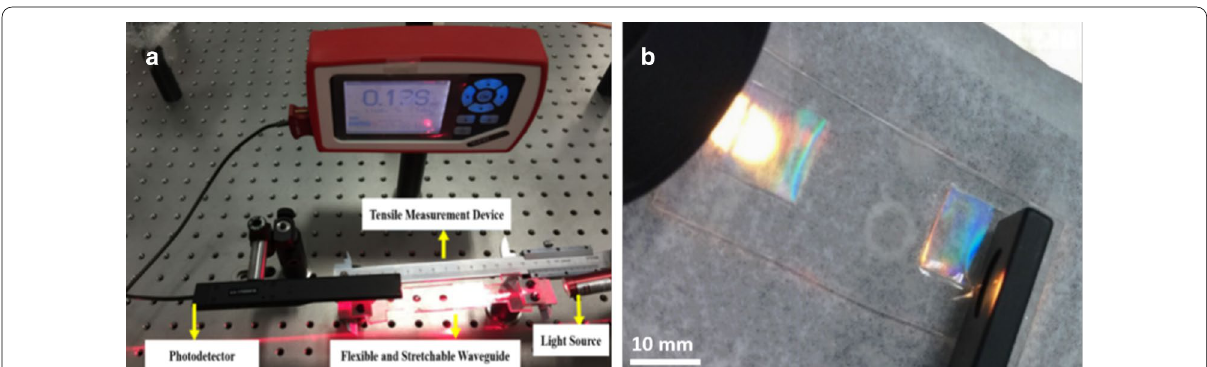
Fig. 6 a The tactile sensing platform, b Nanograting based flexible and stretchable optical